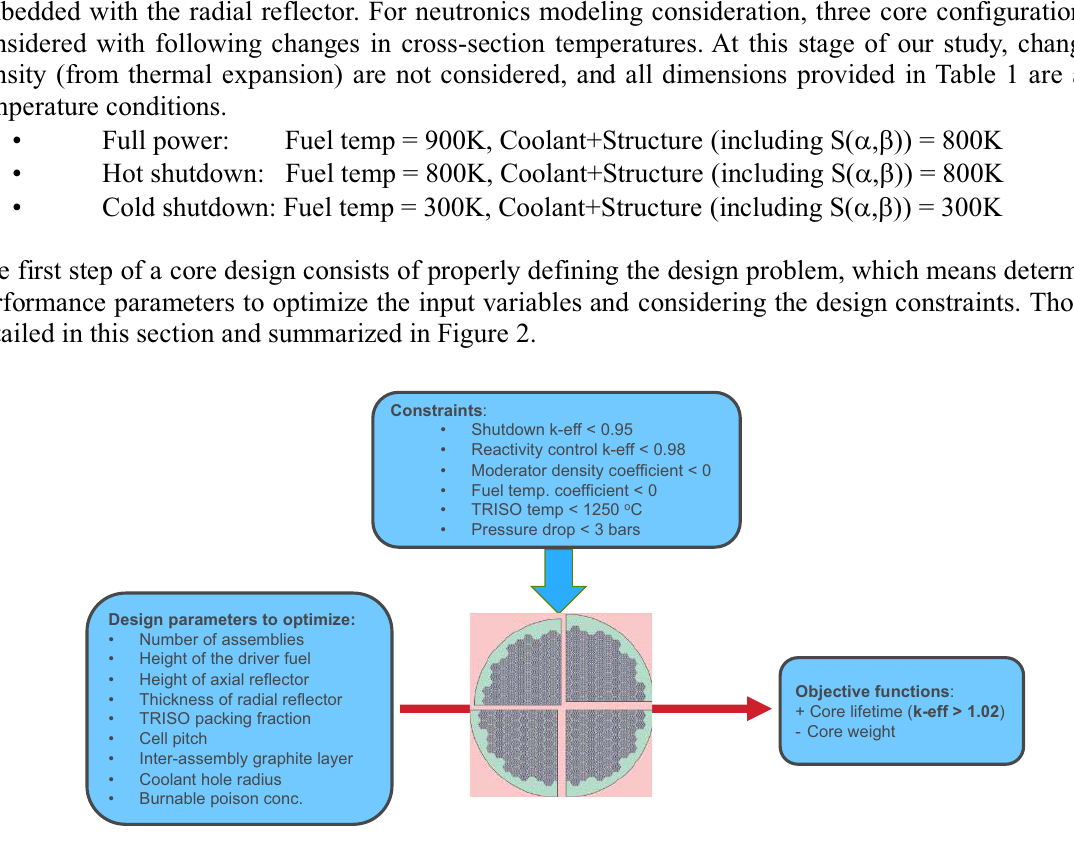
Figure 2. Description of the optimization